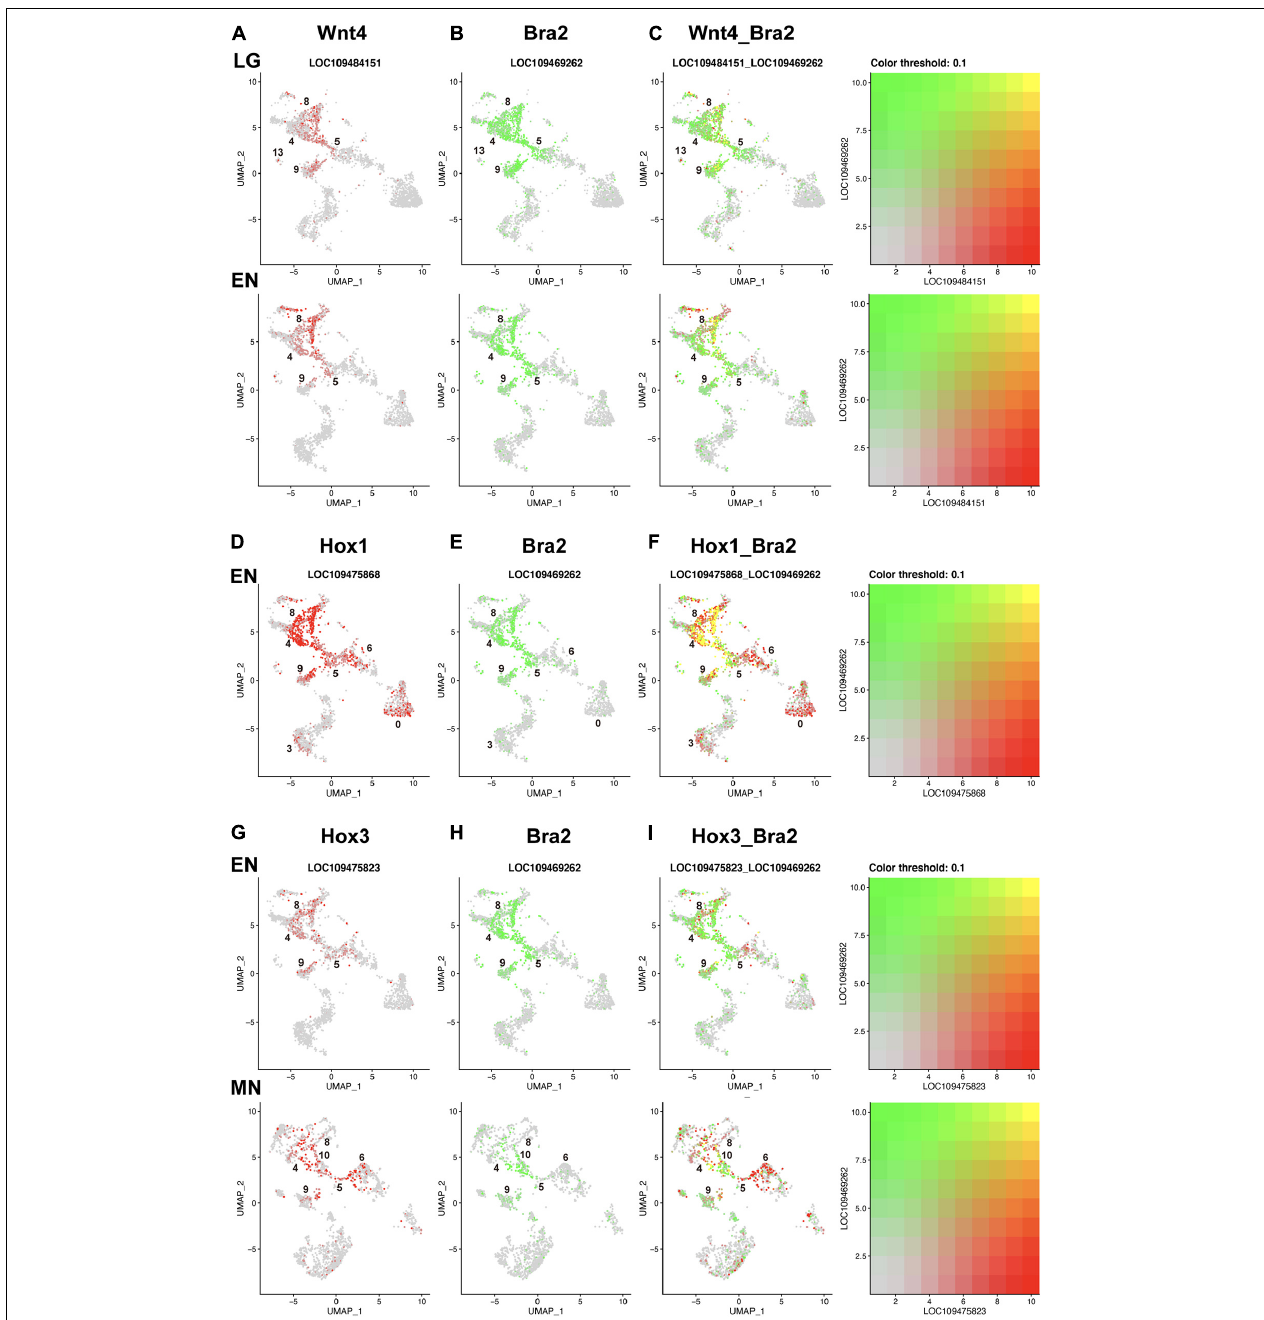
FIGURE 5 | UMAP plots showing co-expression of Wnt and Brachyury , and Hox and Brachyury in amphioxus embryos. (A) Wnt4 (red), (B) Bra2 (green), and (C) co-expression (yellow) of the two genes at late gastrula (LG) and early neurula (EN) stages. Co-expression is seen in cells of clusters 8, 5, and 9. (D) HoxA1 (red), (E) Bra2 (green), and (F) co-expression (yellow) of the two genes at and early neurula (EN) stage. Co-expression is seen in cells of clusters 8, 4, 5, and 9. (G) Hox3 (red), (H) Bra2 (green), and (I) co-expression (yellow) of the two genes at early neurula (EN) and midneurula (MN) stages. Co-expression is seen in cells of clusters 8, 4, 5, 9, and